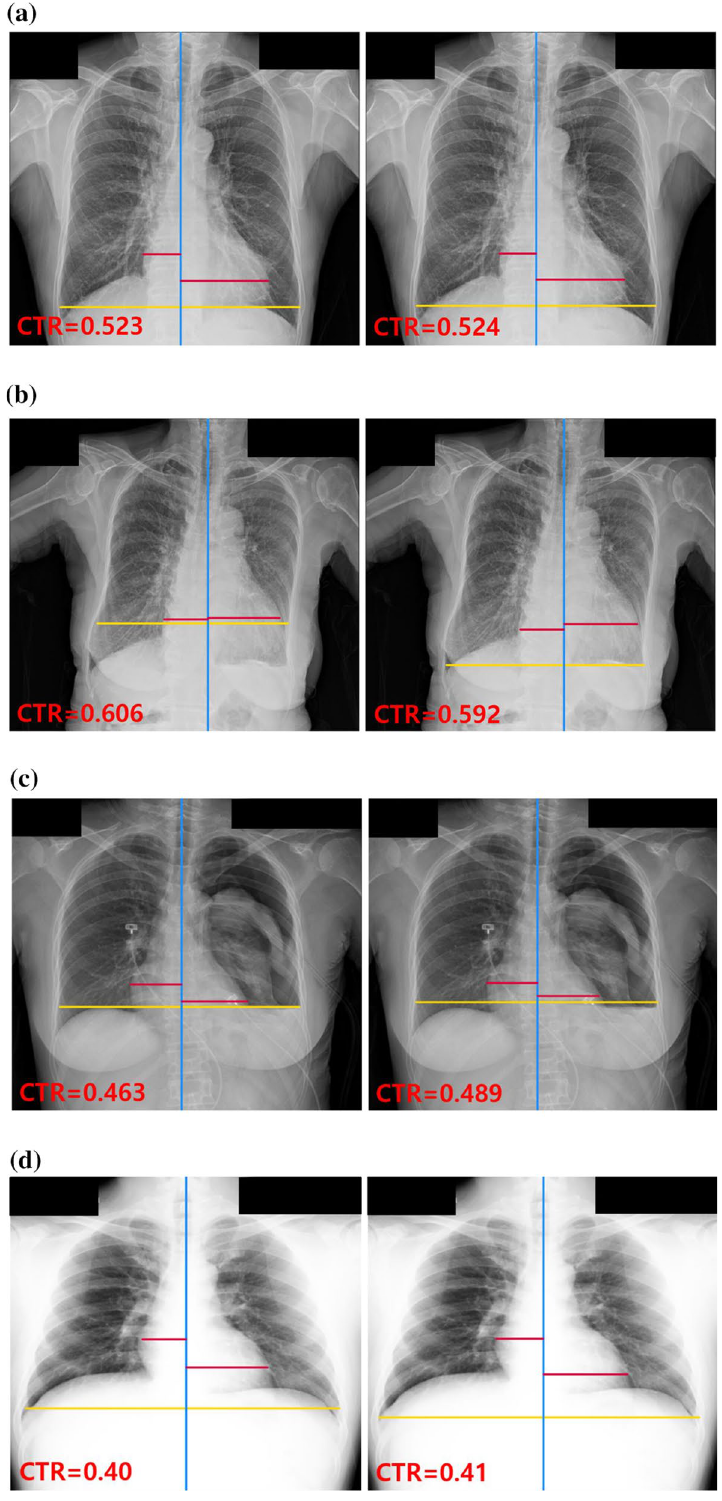
Figure 2. Radiographs of correctly classified examples. CTR values and three lines were generated by segmentation-based methods using deep learning models for the detection of cardiomegaly. The red lines represent the maximum transverse diameter of the left or right side of the heart, respectively; the yellow and blue lines represent the transverse thoracic diameter and the midline of the spine, respectively. For each case, the left image was generated by segmentation-based method 1, and the right image was generated by segmentation-based method 2. ( a ) PA CXR of a patient with cardiomegaly (reference standard [RS] = 0.522); ( b ) PA CXR of a patient with cardiomegaly and pleural effusion (RS = 0.611); ( c ) PA CXR of a patient with pneumothorax, pleural effusion, and left lung collapse, (RS = 0.466); ( d ) PA CXR of a patient with no finding (RS = 0.41). CTR cardiothoracic, PA CXR posterior-anterior chest